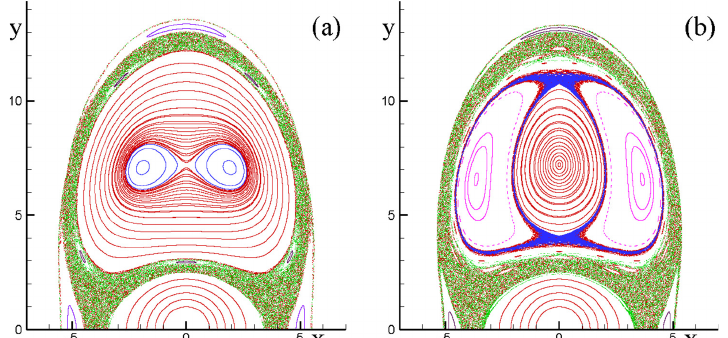
Figure 4. Poincaré maps of the barotropic two-vortex system ( S 0 = − 0.01, Ω 0 = − 0.02, µ 1 = µ 2 = 1) and perturbation magnitude ε = 0.1: ( a ) perturbation frequency ν = 0.08—strongest linear parametric instability in the system linearised near the elliptic fixed point; and ( b ) perturbation frequency ν = 0.07—no linear parametric